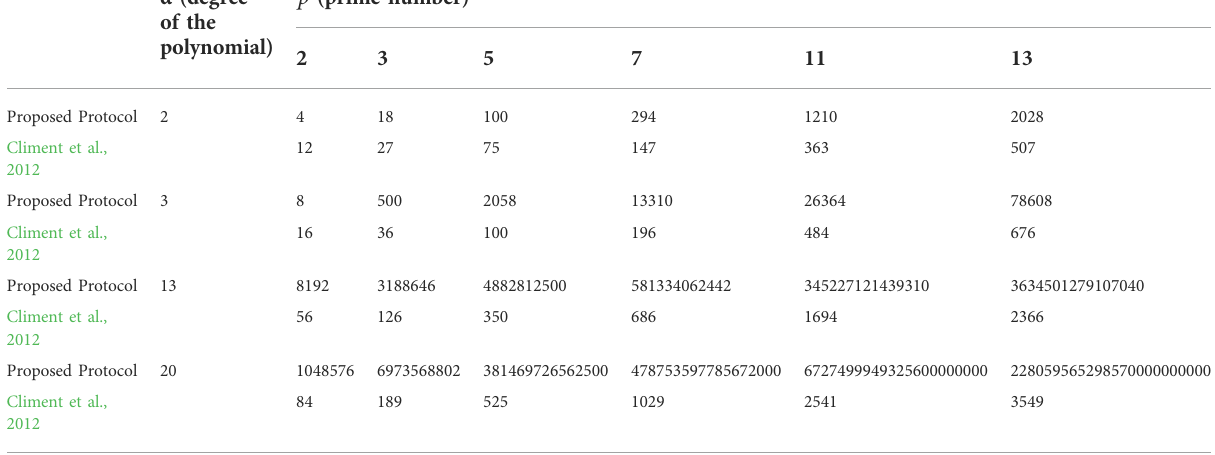
TABLE 1 The size of the set of polynomials of different degrees α and prime p with the order of matrices n (cid:1) 2 . α (degree p (prime number) of the polynomial)